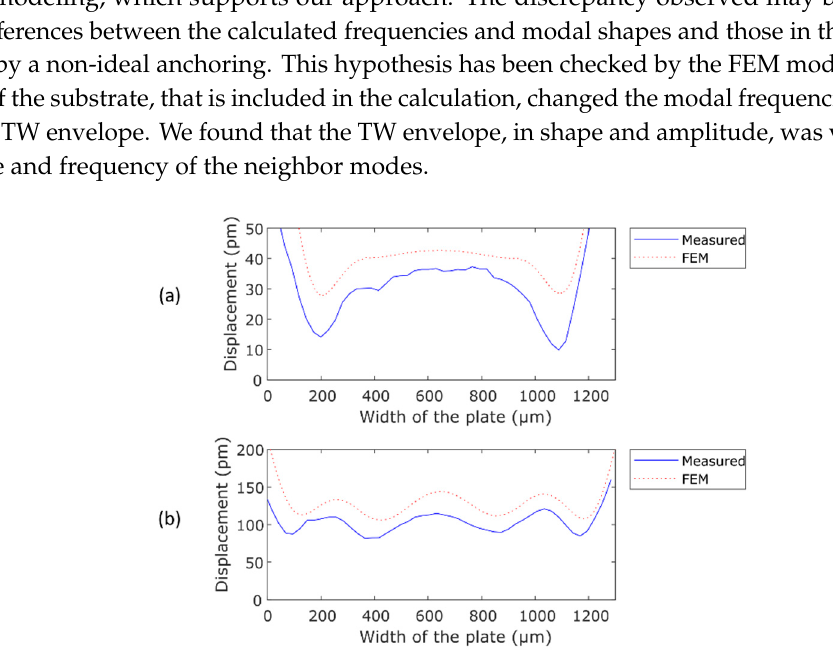
Figure 6. Comparison between the envelope of the measured (blue) and the FEM simulated (red) TW: ( a ) combination of Modes (11) and (12) at 208.4 kHz and ( b ) combination of Modes (22) and (14) at 921.9 kHz.